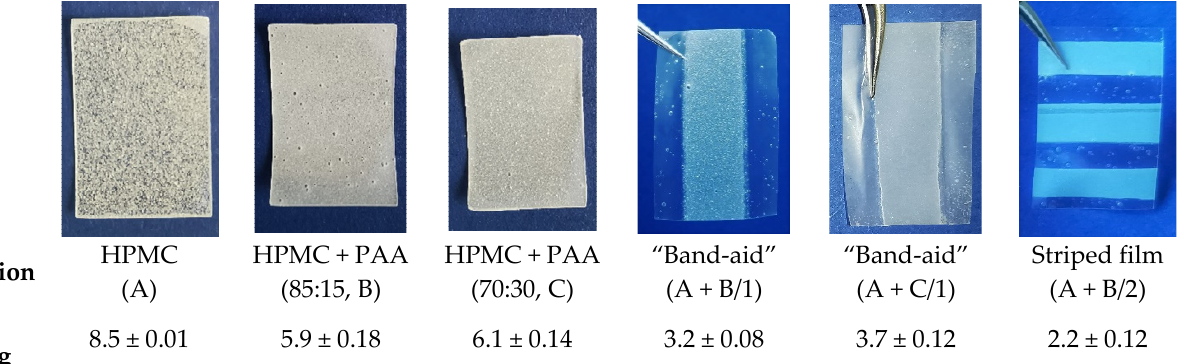
Figure 10. Drug load per film (A: HPMC, B: HPMC + PAA 85:15, C: HPMC + PAA 70:30, n = 3–5, mean ± sd). The pictures were taken in front of blue background.